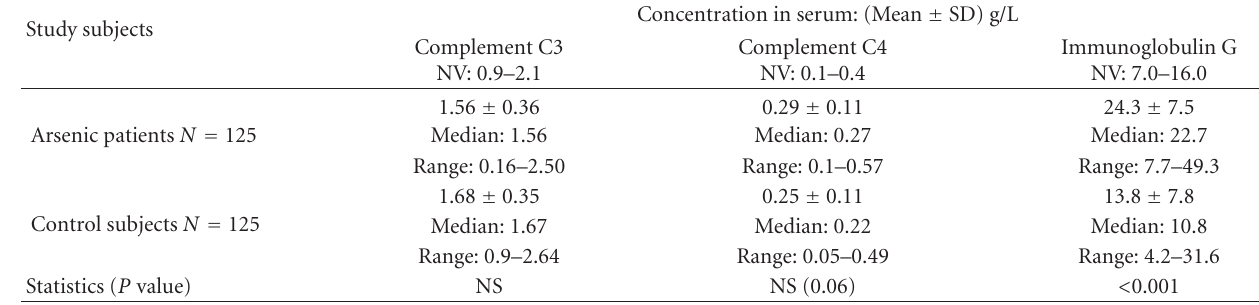
Table 2: Levels of serum complements C3 and C4 and immunoglobulin G in the arsenic patients and control